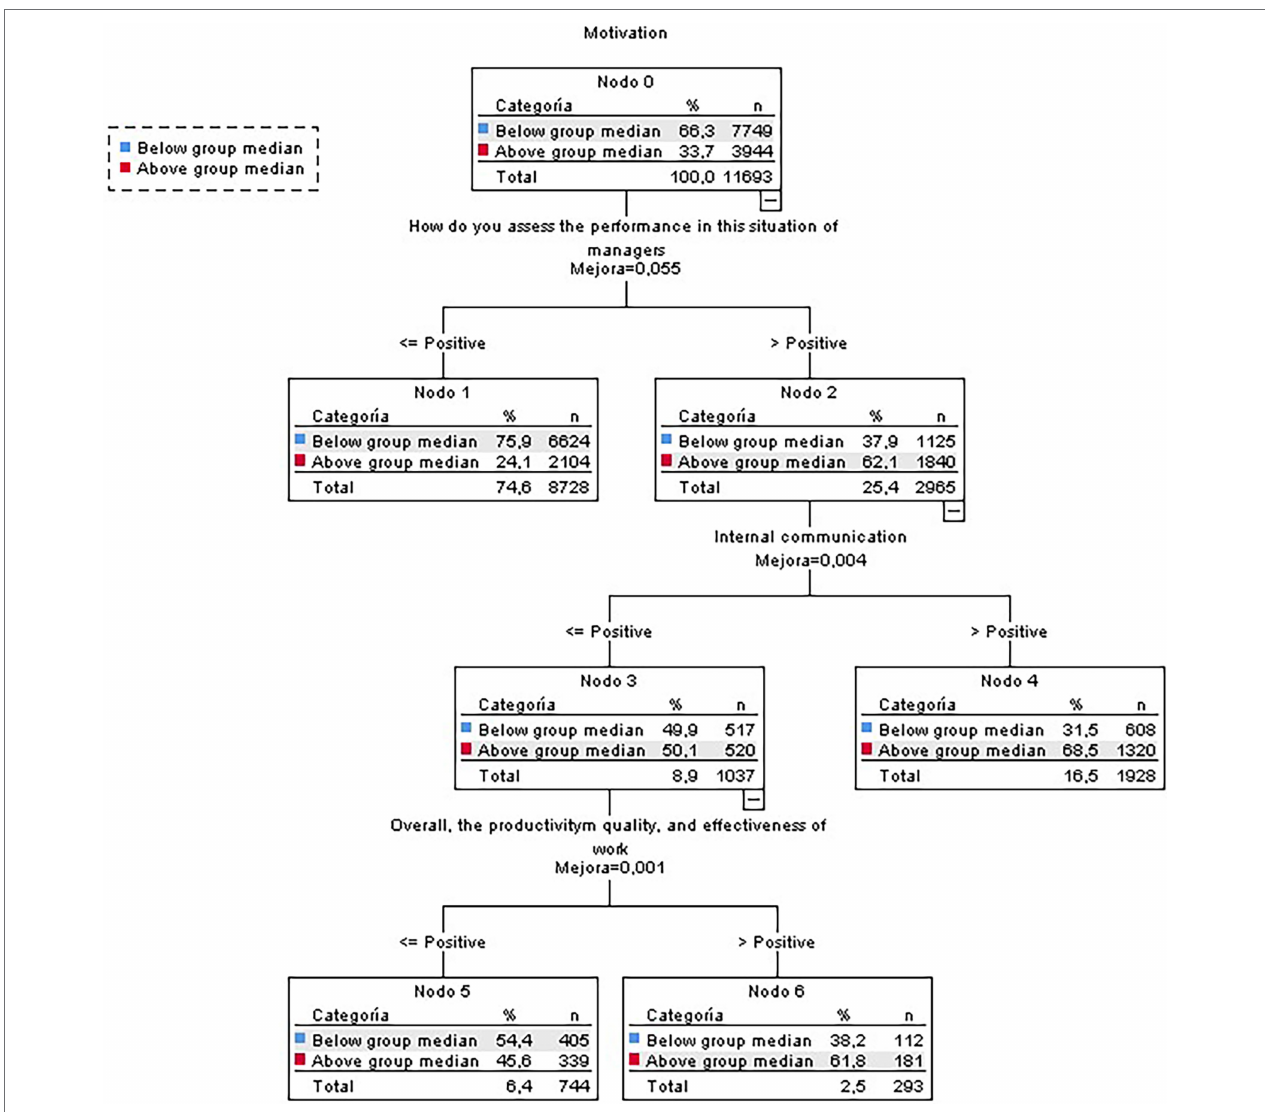
FIGURE 1 | Classification tree for motivation (global